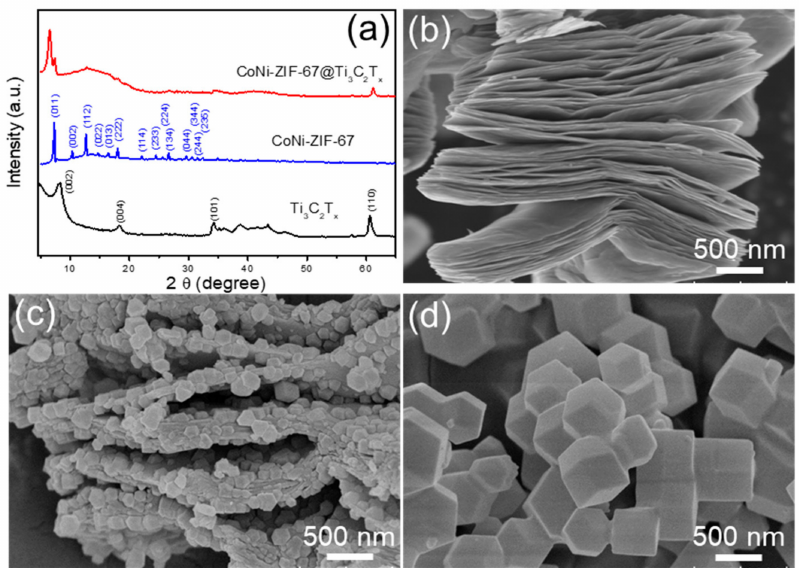
Figure 2. ( a ) X-ray di ff raction (XRD) patterns of Ti 3 C 2 T x , CoNi-ZIF-67@Ti 3 C 2 T x , and pure CoNi-ZIF-67. Scanning electron microscopy (SEM) images of ( b ) Ti 3 C 2 T x ; ( c ) CoNi-ZIF-67@Ti 3 C 2 T x , and ( d ) pure